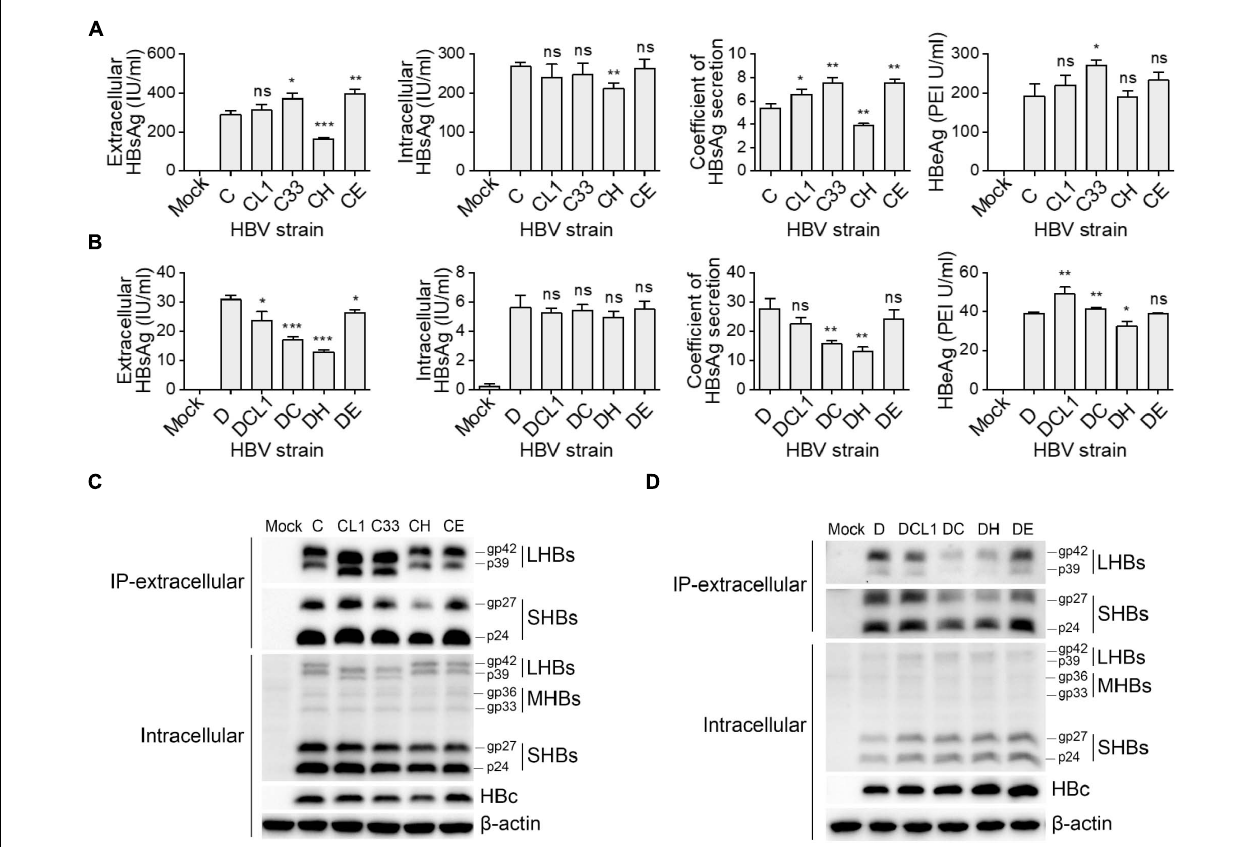
FIGURE 3 | Impact of preS1 N-terminal sequences on HBV protein expression and secretion. Plasmids containing 1.3-mer HBV genome from C-derived (A,C) and D-derived (B,D) strains were transfected into HepG2 cells. Cells and culture supernatant were harvested at day 3 post transfection. (A,B) Extracellular HBsAg and HBeAg and intracellular HBsAg were determined by CLIA kit. (C,D) Western blot detection of intracellular HBs (LHBs, MHBs, and SHBs) and HBc. Extracellular SHBs or LHBs were also detected by Western blot after HBs immunoprecipitation with anti-HBs antibody (Abcam). The glycosylated (gp) and non-glycosylated (p) forms of HBs are indicated. Histograms of (A,B) show mean values from one representative experiment. Bars indicate Standard Deviation. The p values were determined using Student’s t test; ns represents no significant, * p < 0.05, ** p < 0.01, *** p < 0.001. CLIA, chemiluminescence immunoassay; IP, immunoprecipitation; HBV, hepatitis B virus; HBsAg, hepatitis B surface antigen; HBeAg, hepatitis B e antigen; LHBs, HBV large surface protein; MHBs, HBV middle surface protein; SHBs, HBV small surface protein; HBc, HBV core